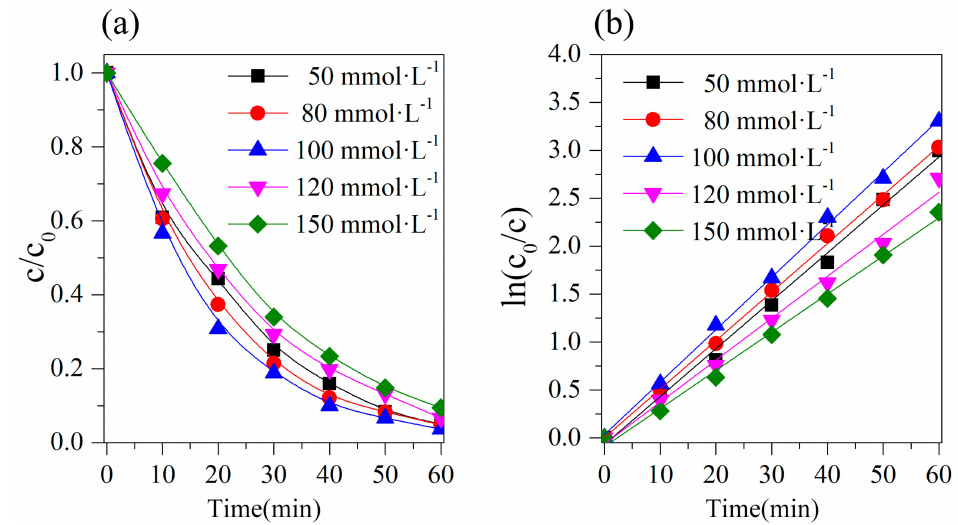
Figure 2. E ff ect of concentration of hydrogen peroxide ( a ); e ff ect of concentration of hydrogen peroxide ( b ) on kinetic constant; [C 4 BthPF 6 ] = 0.1 mM, t = 45 °C, pH = 5.06.